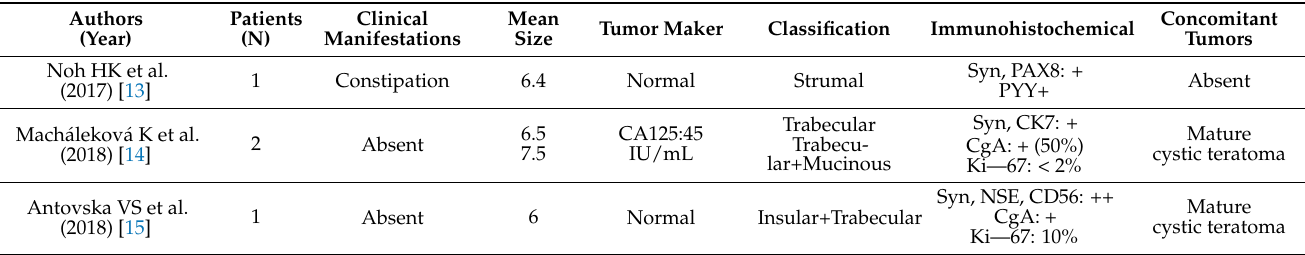
Table 2. Recent case reports of ovarian strumal